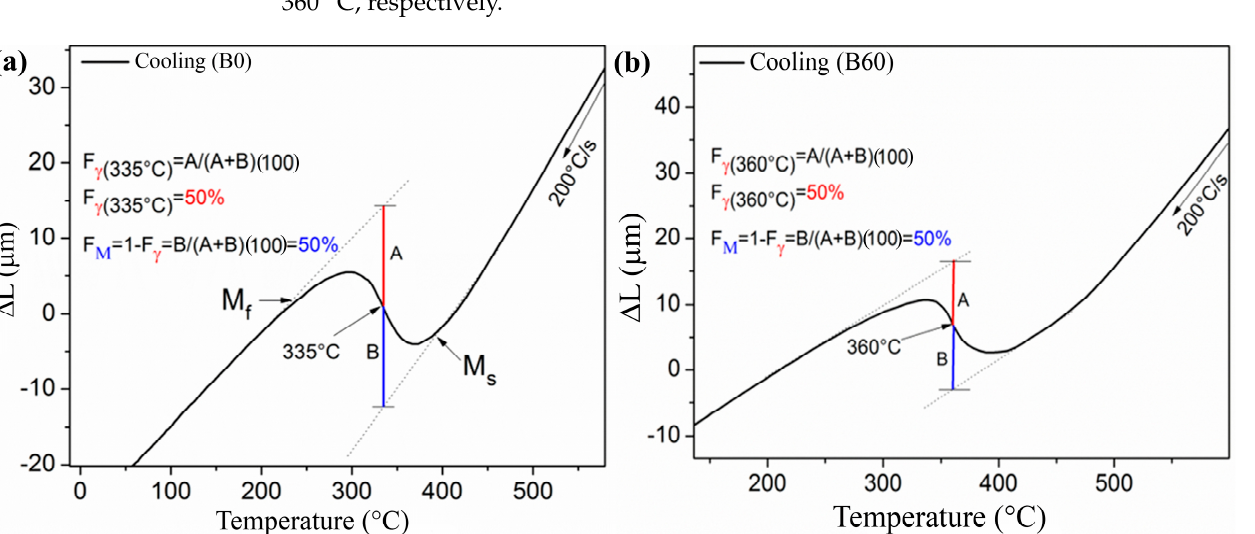
Figure 9. Experimental dilatometry curves for the martensitic transformation: ( a ) boron-free CP-B0 steel, and ( b ) boron containing CP-B60 steel.